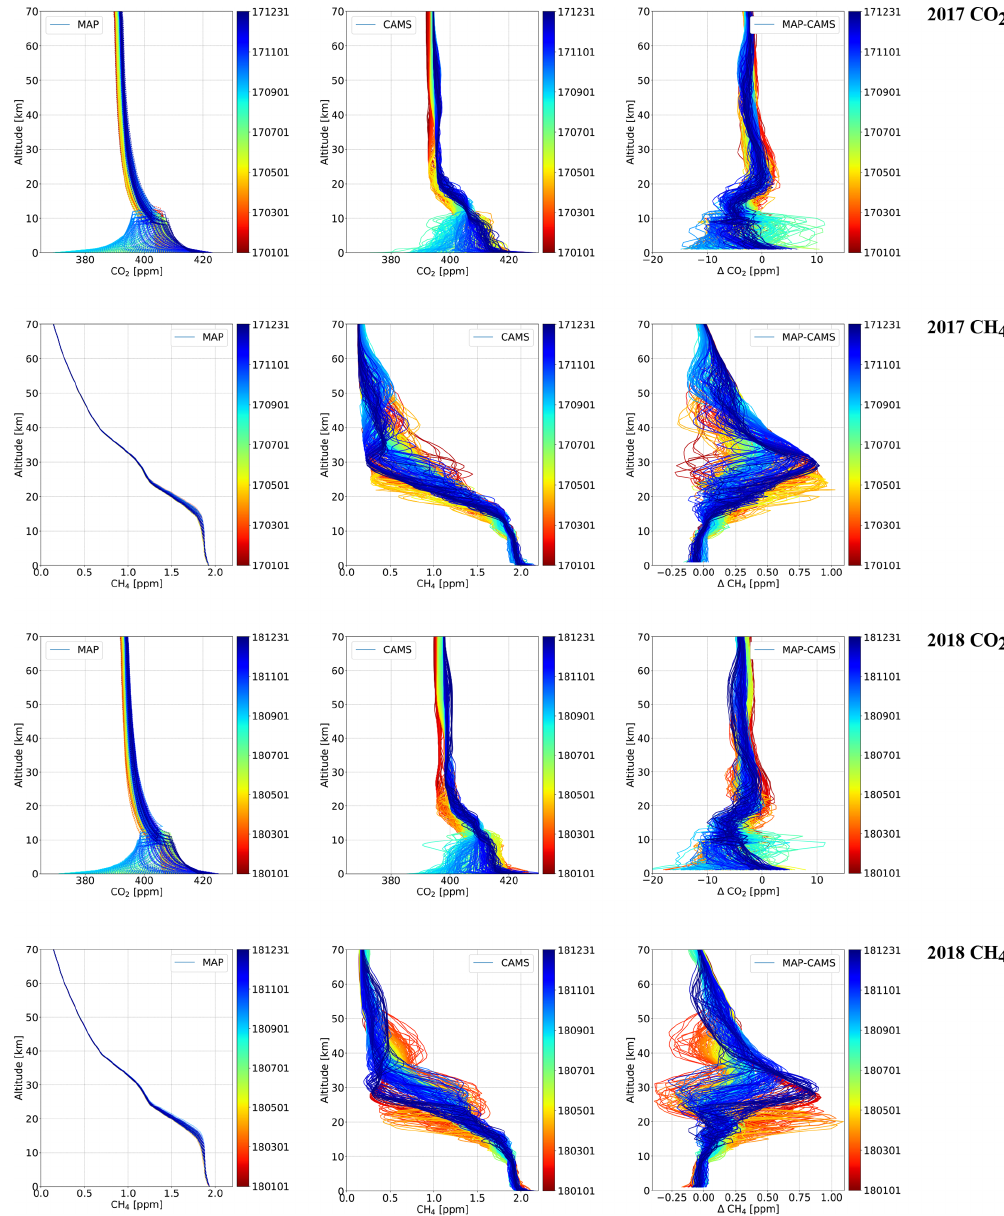
Figure 2. Profiles of MAP (left column), CAMS (middle column), and the difference between MAP and CAMS (right column) for CO 2 and CH 4 in 2017 and